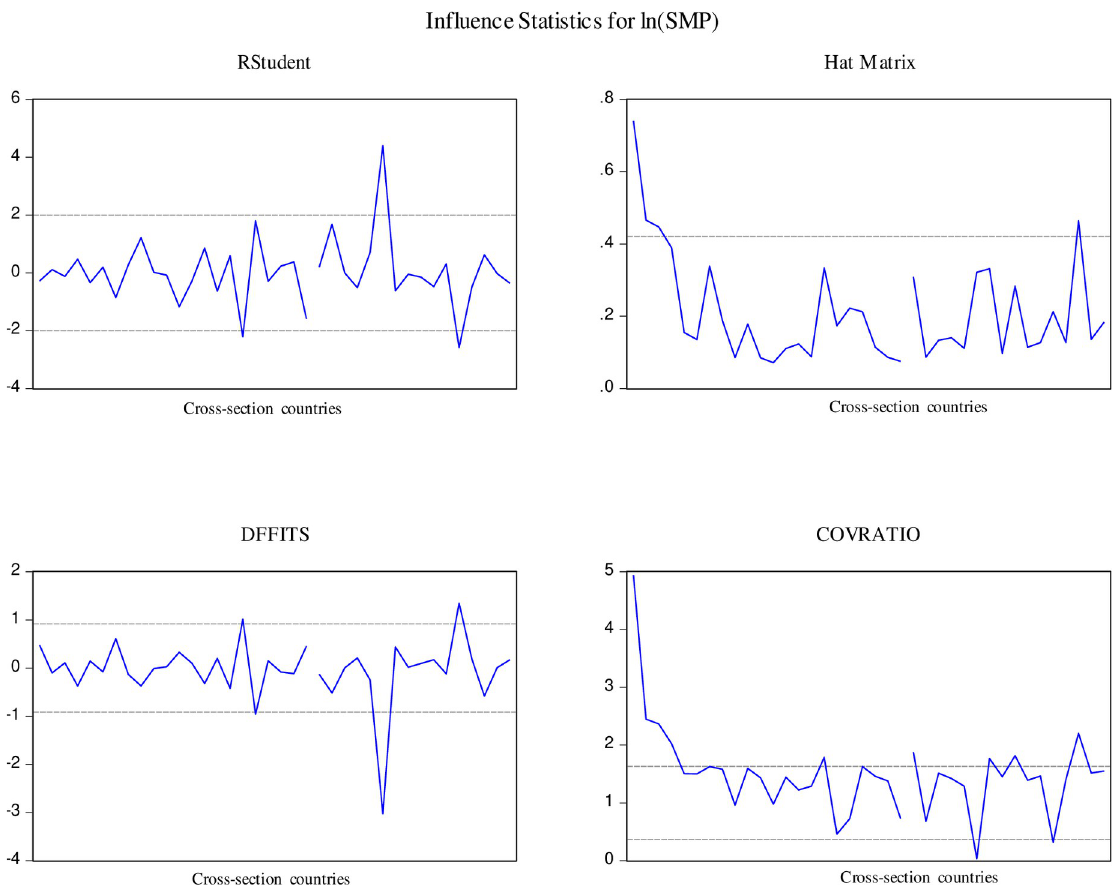
Fig 5. Influence statistics for ln(SMP). Source: Author’s